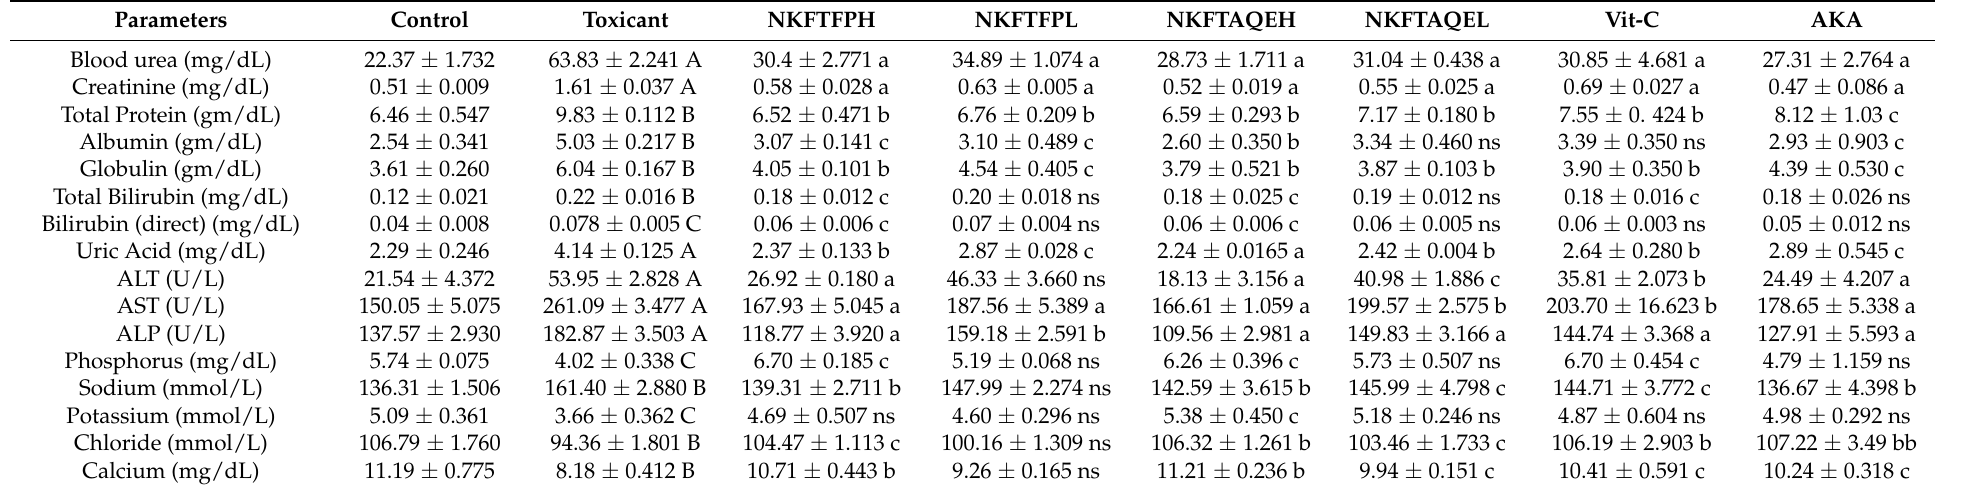
Table 1. Assessment of biochemical markers in serum for the experimental